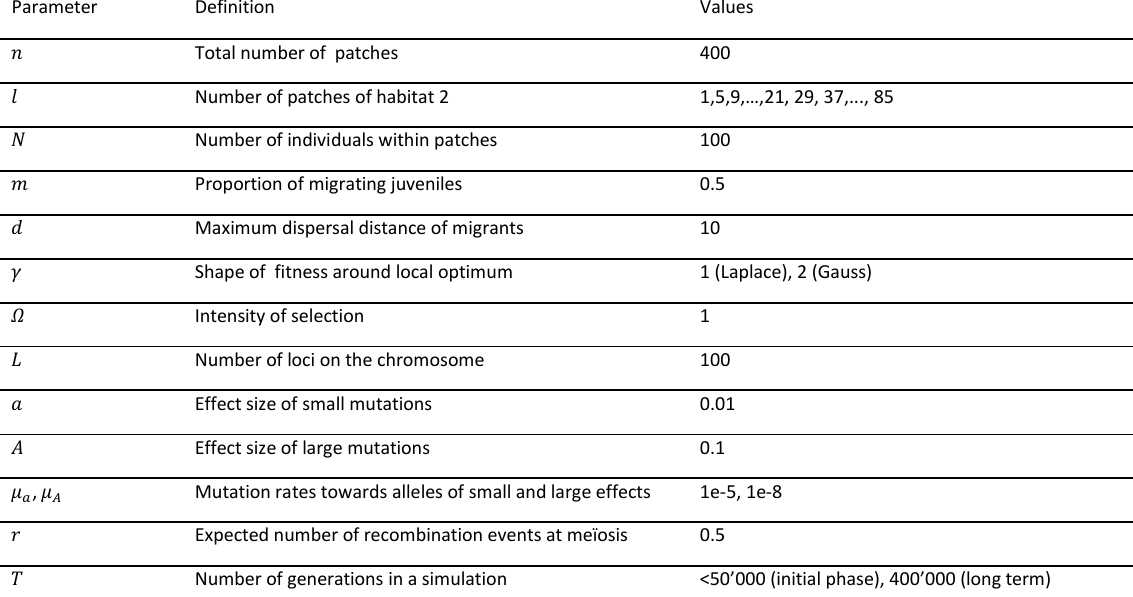
Table 1 - Parameter values used in simulations. List of parameters values used in the simulations. We used fourteen values of 𝑙 , for both long term and initial phase of adaptation, for both Laplace and Gauss fitness functions. We used 20 replicates per combination of parameter values. This resulted in 14 × 2 × 2 × 20 = 1120 simulations. Parameter Definition Values